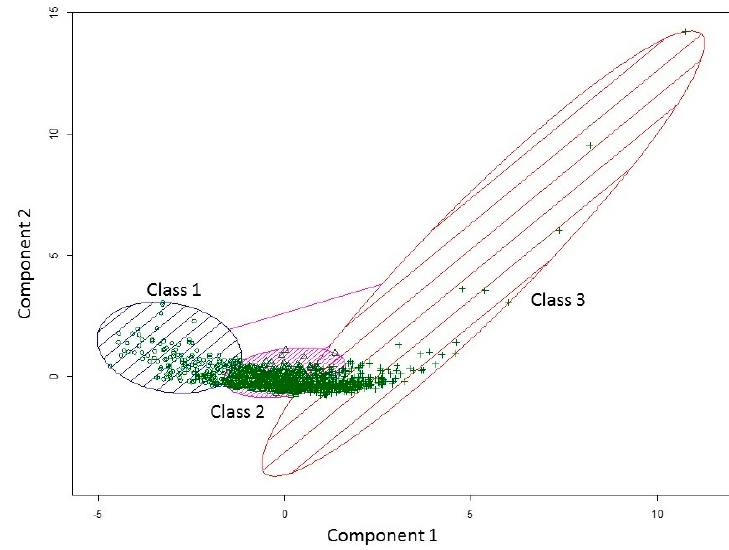
Figure 14. Discriminant analysis results Class 1—Smooth ice, Class 2—Platelet ice, and Class 3— Discriminant analysis results Class 1—Smooth ice, Class 2—Platelet ice, and Unclassified. These two components explain 91.23% of the point variability. Class 3—Unclassified. These two components explain 91.23% of the point